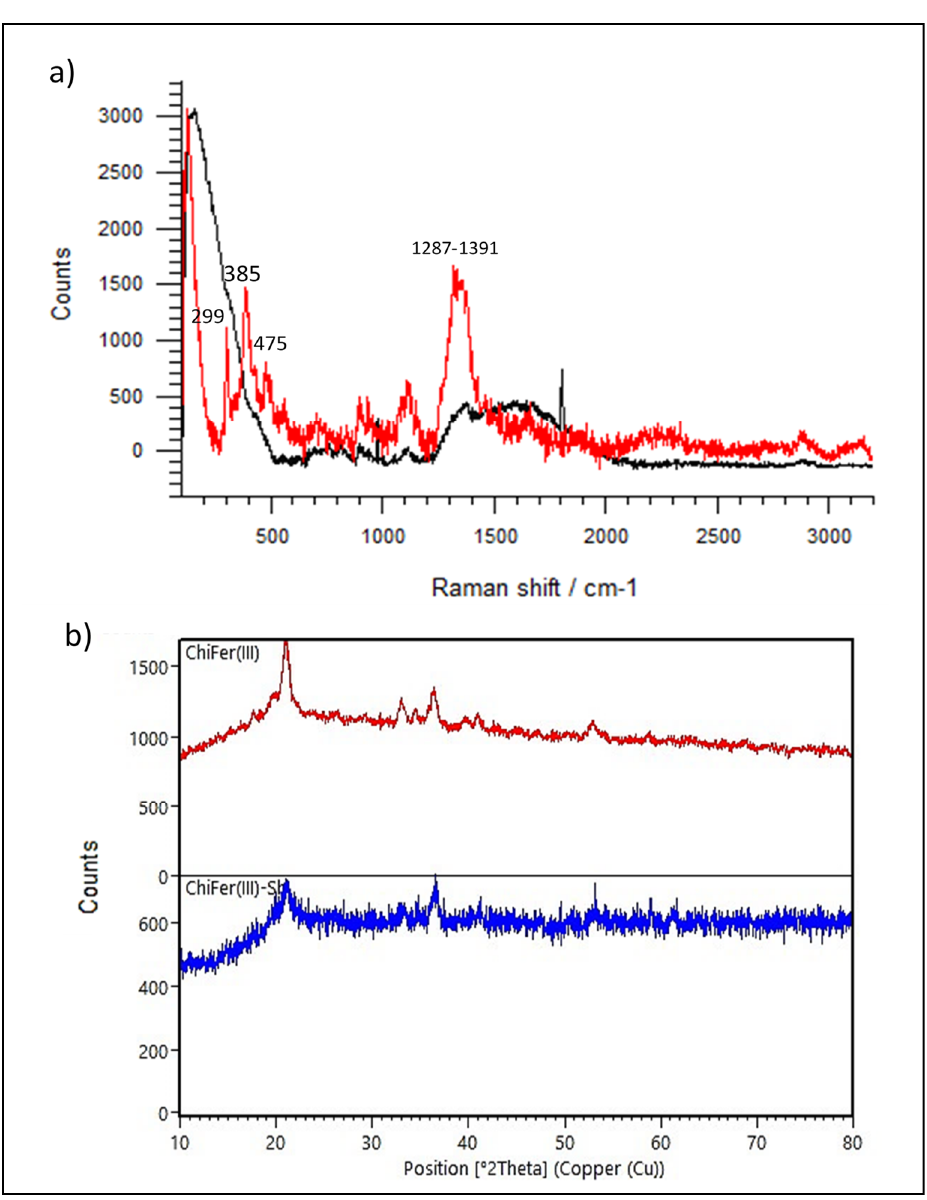
Figure 1. Raman (RS) and X ray diffraction (XRD) spectra. ( a ) Black line: neat CS raman spectra, red line: ChiFer(III) raman spectra. ( b ) Red line: ChiFer(III) XRD spectra, blue line: ChiFer(III) Sb-loaded XRD spectra.